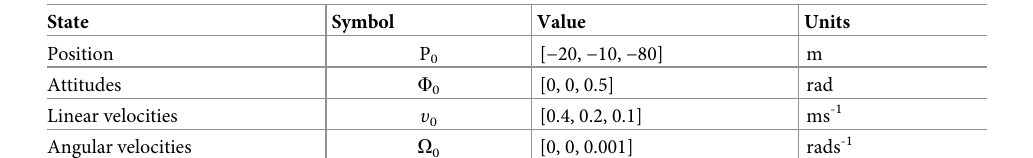
tion results for the uncertainty vector are summarized in Fig 5. The value of Δ F seconds is zero because � F ¼ F , where � F is the aerodynamic model used in the simulator AD AD AD design and F is in the estimator design. However, the simulator model observes δ change AD that alters the model uncertainty vector. Fig 6 shows the estimation error and error bounds for the estimated states and uncertainty vector. Table 1. Initial conditions for airship